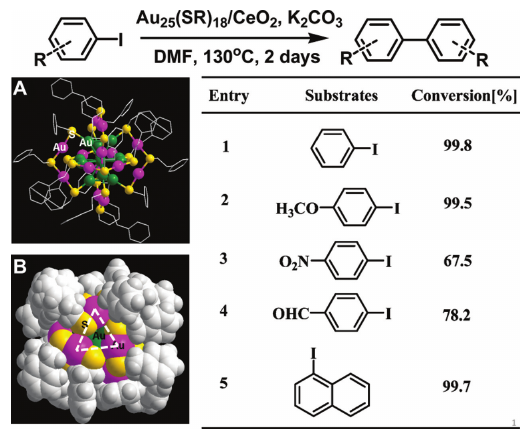
Table 1 Homocoupling of aryl iodides using Au Crystalline structure of Au model and the triangular catalytic active sites. From ref. [34] with